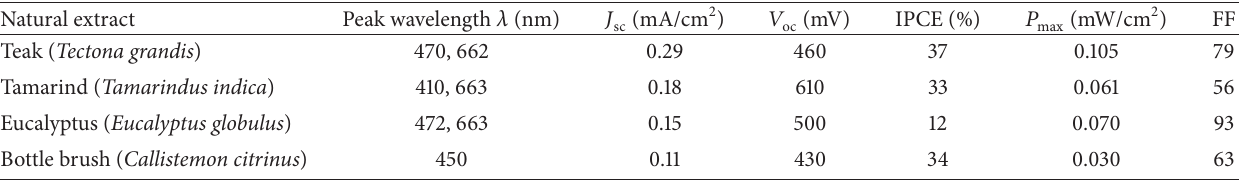
Table 1: The cell output of DSSCs sensitized by four kinds of natural dyes: (a) teak, (b) tamarind, (c) eucalyptus, and (d) bottle brush under visible light (256mW/cm 2 )